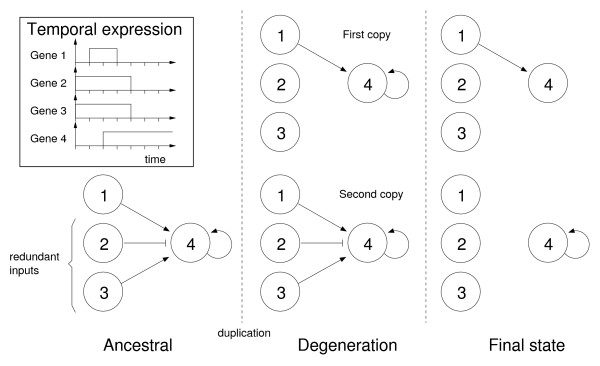
An example of the dominance effect following duplication. The inset (top left) gives an example time course for the protein products of the four genes. Regulation of gene 4 in the ancestral network includes two redundant interactions from genes 2 and 3, which cannot be removed in succession without perturbing the dynamics (since genes 2 and 3 have identical dynamics, their contributions cancel out). However, following duplication, these interactions can be lost successively (albeit in order, with the input from gene 3 degenerating first), since any dynamic perturbations will be masked by the intact second copy. Since the first copy now produces the correct dynamics, the degeneration process can be repeated in the second copy. Further degeneration might lead to a final state of complementation between the two copies.